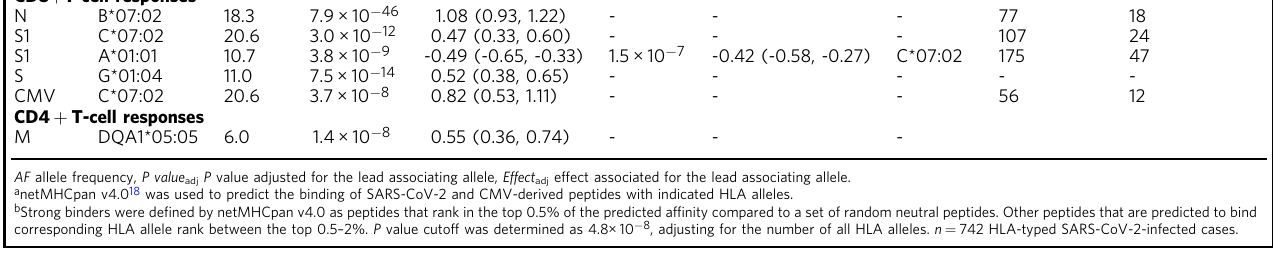
CD4 + or CD8 + T-cell responses between males and females (Supplementary Table 6).